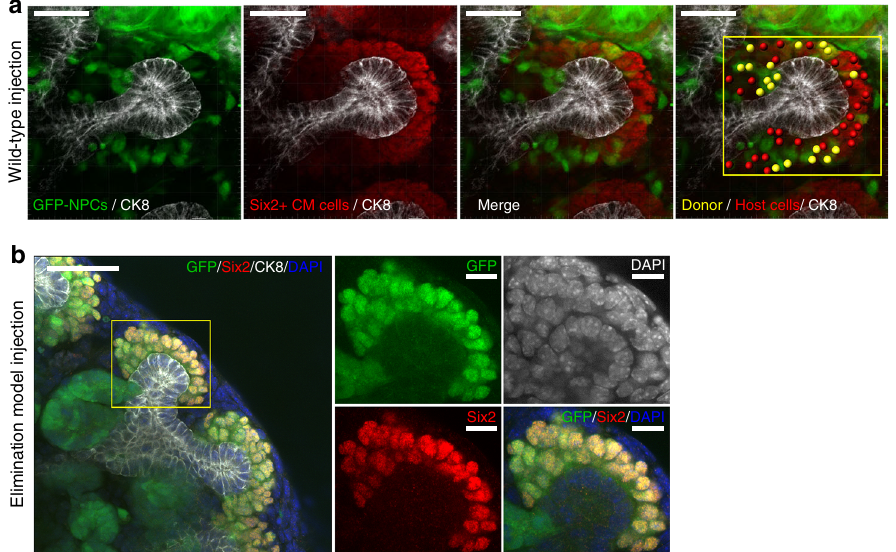
Fig. 2 Representative images of cap mesenchyme (CM) which injected GFP nephron progenitor cells. a Nephron progenitor cells (NPCs)-expressing GFP were transplanted into the nephrogenic zone in the wild-type metanephros (MN). Whole-mount immuno fl uorescence of the cultured MN was used to count the numbers of injected NPCs remaining in the CM. Right column showed that the red spot was host NPCs (Six2 positive) and the yellow spot was donor NPCs (Six2 and GFP positive). The yellow square was an analysis area. a scale bar, 40 µ m. b NPCs expressing GFP were transplanted into the nephrogenic zone in the elimination model of Six2-Cre-inducible diphtheria toxin receptor (iDTR) MN. The yellow square was CM area. Right column was high magni fi cation views. a scale bar, left: 40 µ m. right: 10 µ m. Each MN were subjected to organ culture for 5